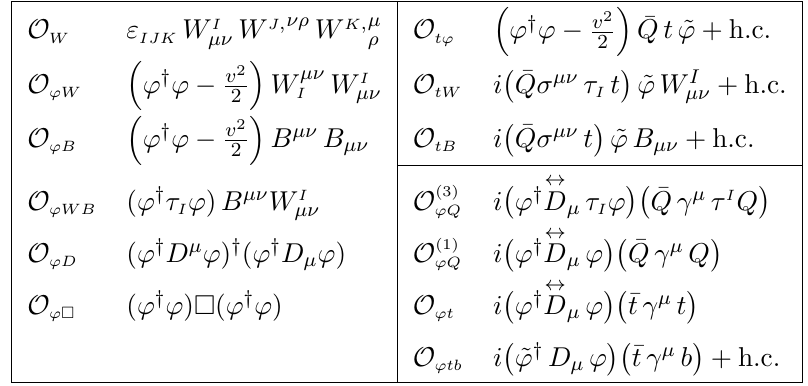
Table 1. SMEFT operators describing new interactions involving the EW and top quark sec- tors, consistent with a U(3) 3 U(2) 2 (cid:13)avour symmetry. Q; t and b denote the third generation (cid:2) components of q; u and d